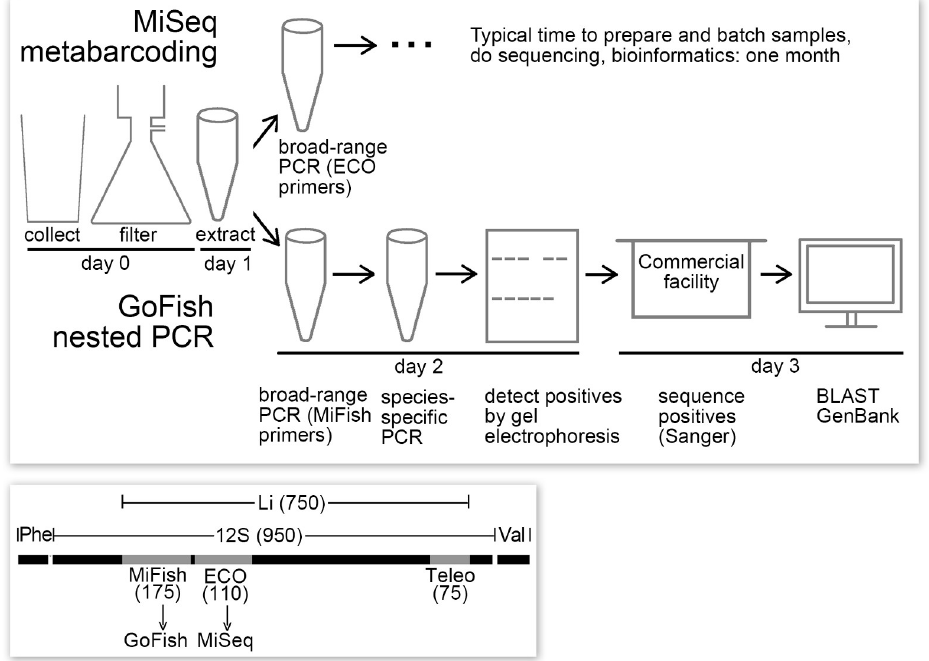
Fig 1. GoFish eDNA assay. Top, schematic of GoFish and MiSeq metabarcoding protocols. Bottom, diagram of 12S and flanking tRNA genes, with locations and sizes of vertebrate metabarcoding targets (MiFish, ECO, Teleo) and the Li segment sequenced from reference specimens as indicated. Typical times for assays are shown; a suitably equipped and staffed laboratory could perform MiSeq metabarcoding in a similar time frame as GoFish.